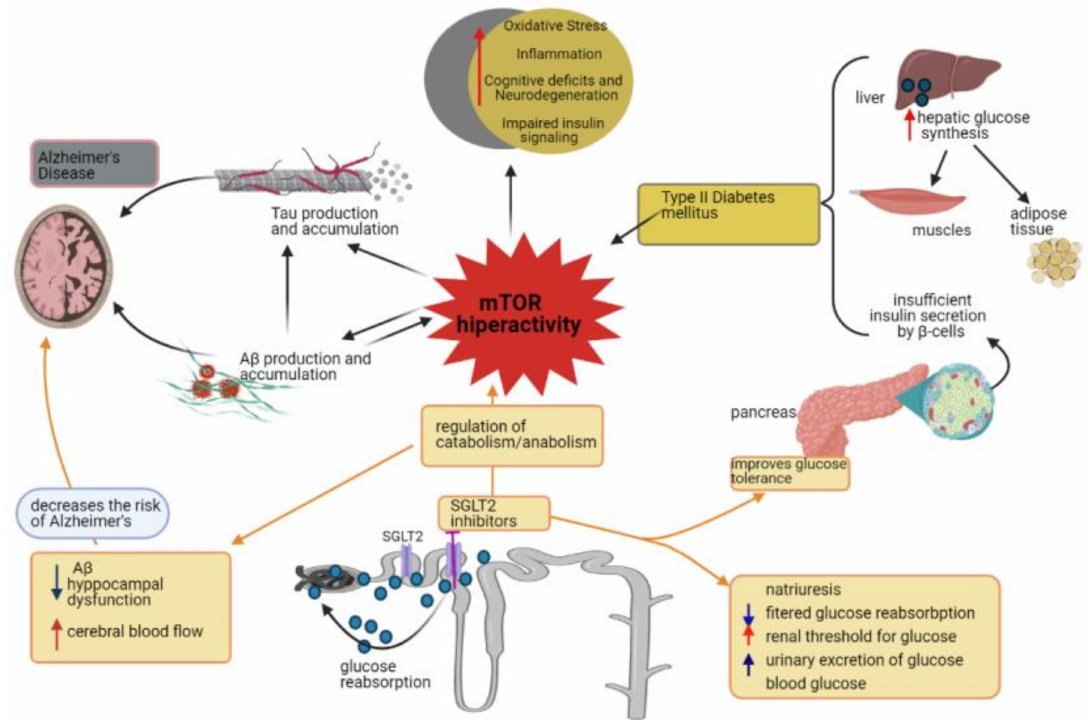
Figure 3. Type 2 diabetes is characterized by insulin resistance caused by uncontrolled hepatic glucose synthesis and by reduced uptake of glucose by muscle and adipose tissue. The pancreas contains functional β cells, but the variable secretion of insulin affects the maintenance of glucose homeostasis because β cells are gradually reduced. AD is characterized by increased synthesis and accumulation of tau and β -amyloid proteins. A β plaques may induce insulin resistance. Cerebral glucose metabolism consists of glucose transport and intracellular oxidative catabolism, affecting this metabolism favoring the appearance of metabolic abnormalities highlighted in the brains of patients with AD. Chronic activation of mTOR may be responsible for as endo-lysosomal, mitochondrial and metabolic dysfunctions in AD. High glucose intake causes hyperactivation of mTOR with abnormal insulin signaling accompanied by accelerated progression and symptoms similar to AD and with hyperglycemia and the appearance of type 2 diabetes. In patients with type 2 diabetes and AD it occurs: increased oxidative stress, inflammation, cognitive deficit and insulin resistance. Type 2 diabetes therapies based on type 2 co-transport inhibitors for sodium and glucose promotes: natriuresis, reduced filtered glucose reabsorption, decreased renal threshold for glucose, increased urinary glucose excretion followed by reduced plasma glucose levels. These compounds have a positive impact on the restoration of the anabolic/catabolic cycle and represent a new way to treat AD. AD, Alzheimer’s disease; A β , amyloid β ; SGLT2, sodium glucose cotransporter 2; mTOR, mechanistic target of